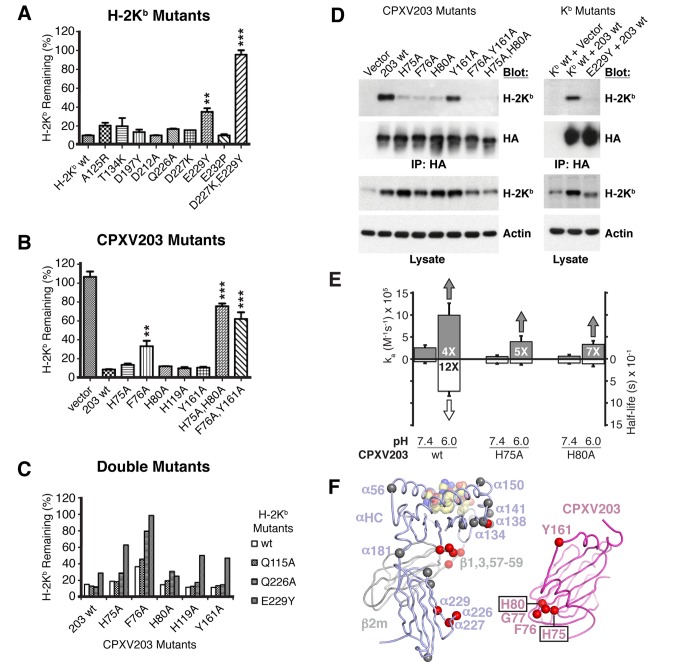
Mutagenesis supports a tri-domain interface and pH regulation.(A–C) 3KO cells stably transduced with β2m and Kb (3KO-β2m-Kb) were transduced with CPXV203-IRES-GFP to evaluate the effect of CPXV203/MHCI interface mutation on surface Kb remaining relative to untransduced cells. Comparable expression of wild-type and mutant proteins was determined using co-expressed GFP and/or western blotting. Each figure represents the data from two independent experiments. **p<0.01; ***p<0.001 when compared with wild type. Limited MHCI escape was observed for two single α3 interface mutations (Kb E229Y or CPXV203 F76A), while significant Kb escape required double mutation of the α3 interface (Kb D227K/E229Y, CPXV203 H75A/H80A, Kb Q226A/CPXV203 F76A, Kb E229Y/CPXV203 H75A, Kb E229Y/CPXV203 F76A) or simultaneous mutation of interfaces α2 and α3 (CPXV203 F76A, Y161A) (D) Most mutant CPXV203-HA exhibited a decreased ability to co-IP Kb even though surface Kb (%) did not increase significantly. CPXV203/Kb mutations that significantly increased surface Kb expression also exhibited a decrease in total Kb (lysate), indicative of the release of MHCI retention [28]. (E) Kinetic analysis (SPR) of alanine mutation of α3 interface histidines (CPXV203 H75 and H80) summarized by on-rate (ka, (+)-axis) and half-life (half-life, (−)-axis). (F) Summary of mutagenic analysis (functional and biosensor) mapped to CPXV203/MHCI structure (same colors as Figure 3A) shown as cartoon loops except for the peptide (spheres). Mutated residues (Cα spheres) were colored to indicate whether they had a significant effect (red) or no significant effect (grey). CPXV203 and MHCI have been translated apart (x-axis) to highlight corresponding interface mutations. See also Tables S6, S7.